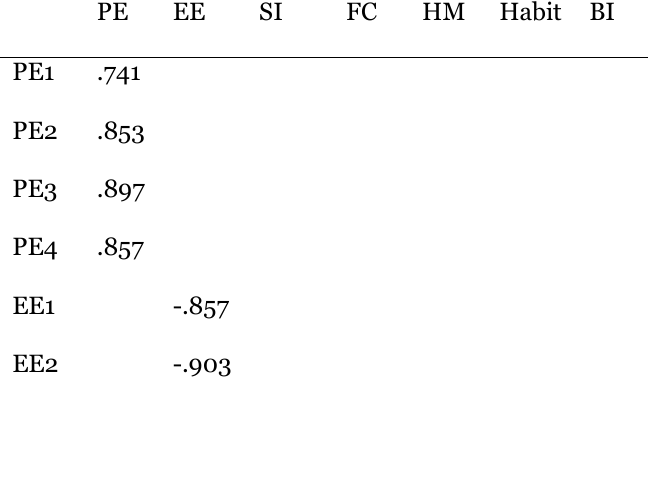
Factor Loadings on the UTAUT Construct